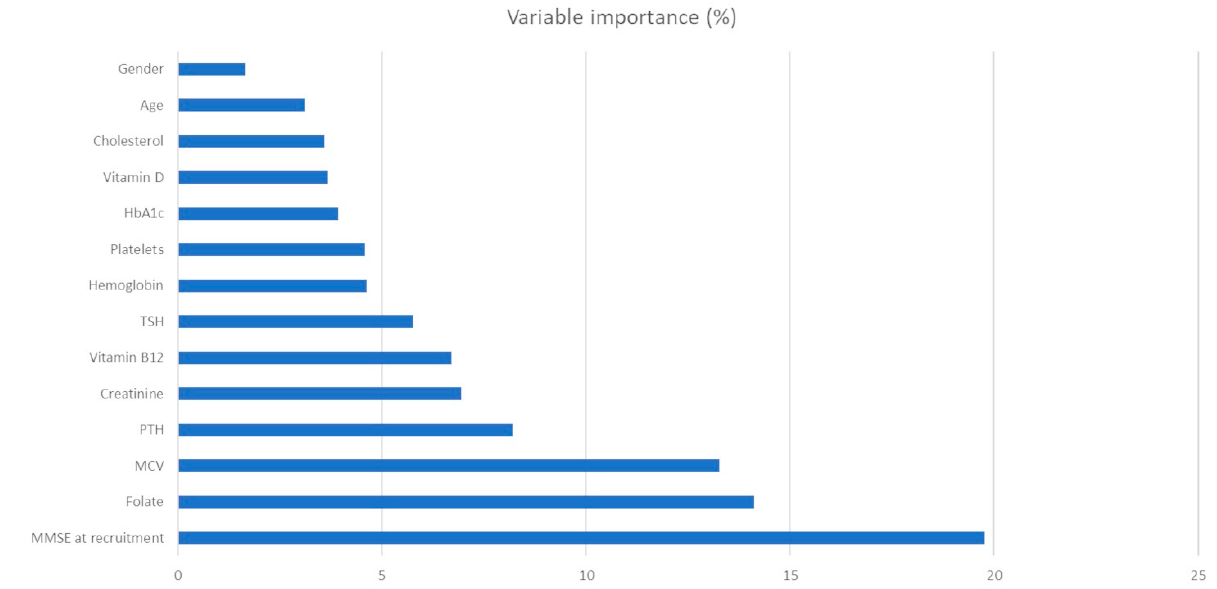
Figure 6. Variable importance for the Random Forest model.